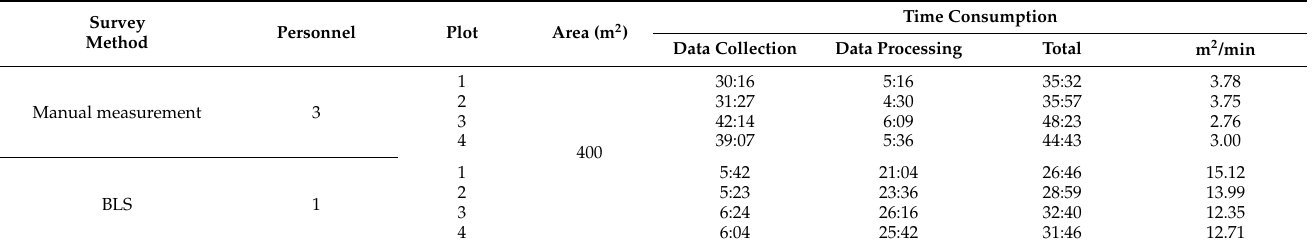
Table 5. Comparison of the efficiency of manual measurement methods with BLS survey